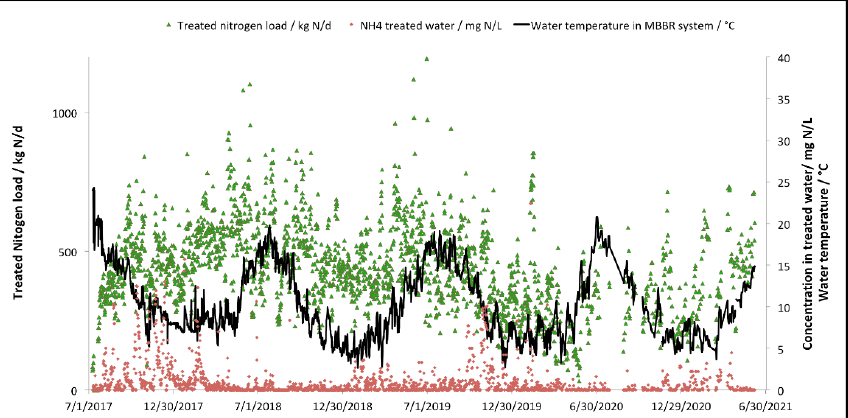
Figure 7. Total nitrogen treated load and water temperature variation in the two-stage MBBR process, along with the final ammonia concentration from the second MBBR stage.